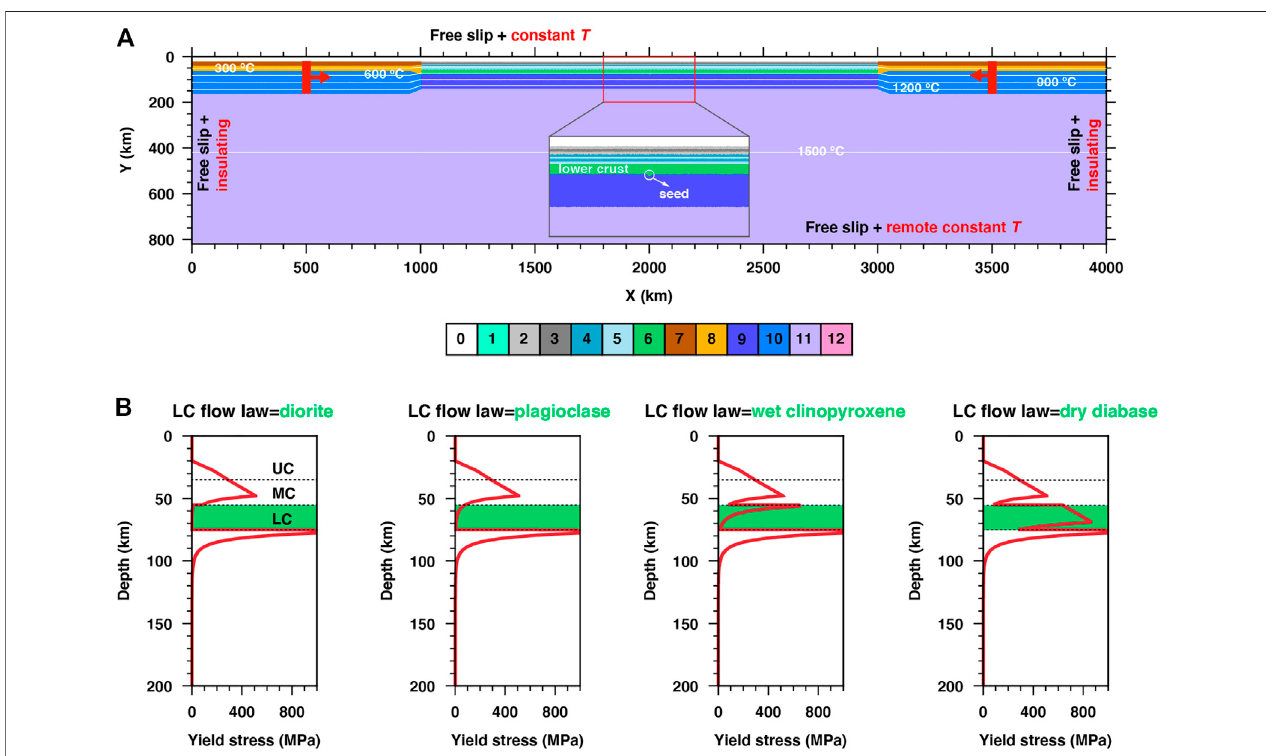
FIGURE 2 | (A) Model setup illustrating the initial model con fi guration and thermal-mechanical boundary conditions. The red vertical bars with lateral arrows show the locations where convergence rates are imposed. White thin lines are isotherms with an interval of 300 ℃ . The composition codes are: 0, sticky air; 1, water; 2 and 3, orogenuppercrust;4and5,orogenmiddlecrust;6,orogenlowercrust;7,cratonuppercrust;8,cratonlowercrust;9,orogenlithospheremantle;10,cratonlithosphere mantle; 11, asthenosphere; 12, partially molten lower crust. (B) Lithosphere yield stress pro fi les for orogen lithosphere. The pro fi les are calculated with a constant strain rate of 10 − 16 1/s and initial temperature shown in (A) , both of which are variable in modeling. See Table 1 for all the rheological parameters. LC, lower